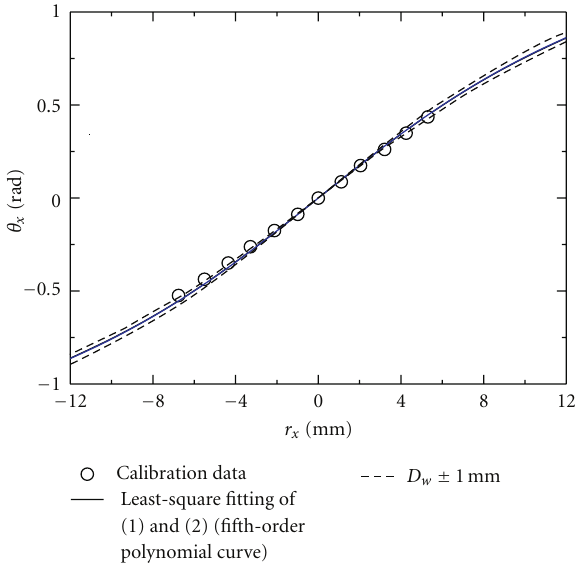
Figure 3: Plot of free surface slope angle as a function of displace- ment on optical